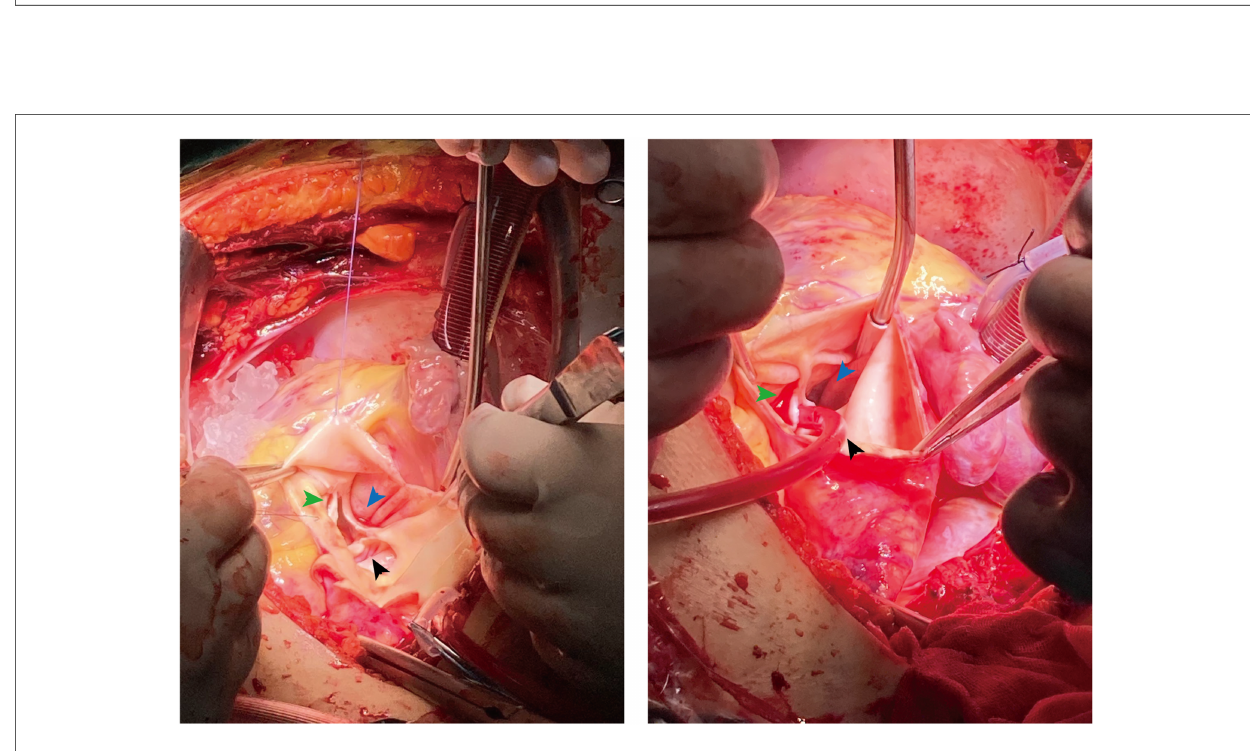
FIGURE 4 Intraoperative images con fi rmed the dual unruptured left (black arrow)/non-coronary (blue arrow) SVAs. The right coronary sinus (green arrow) was